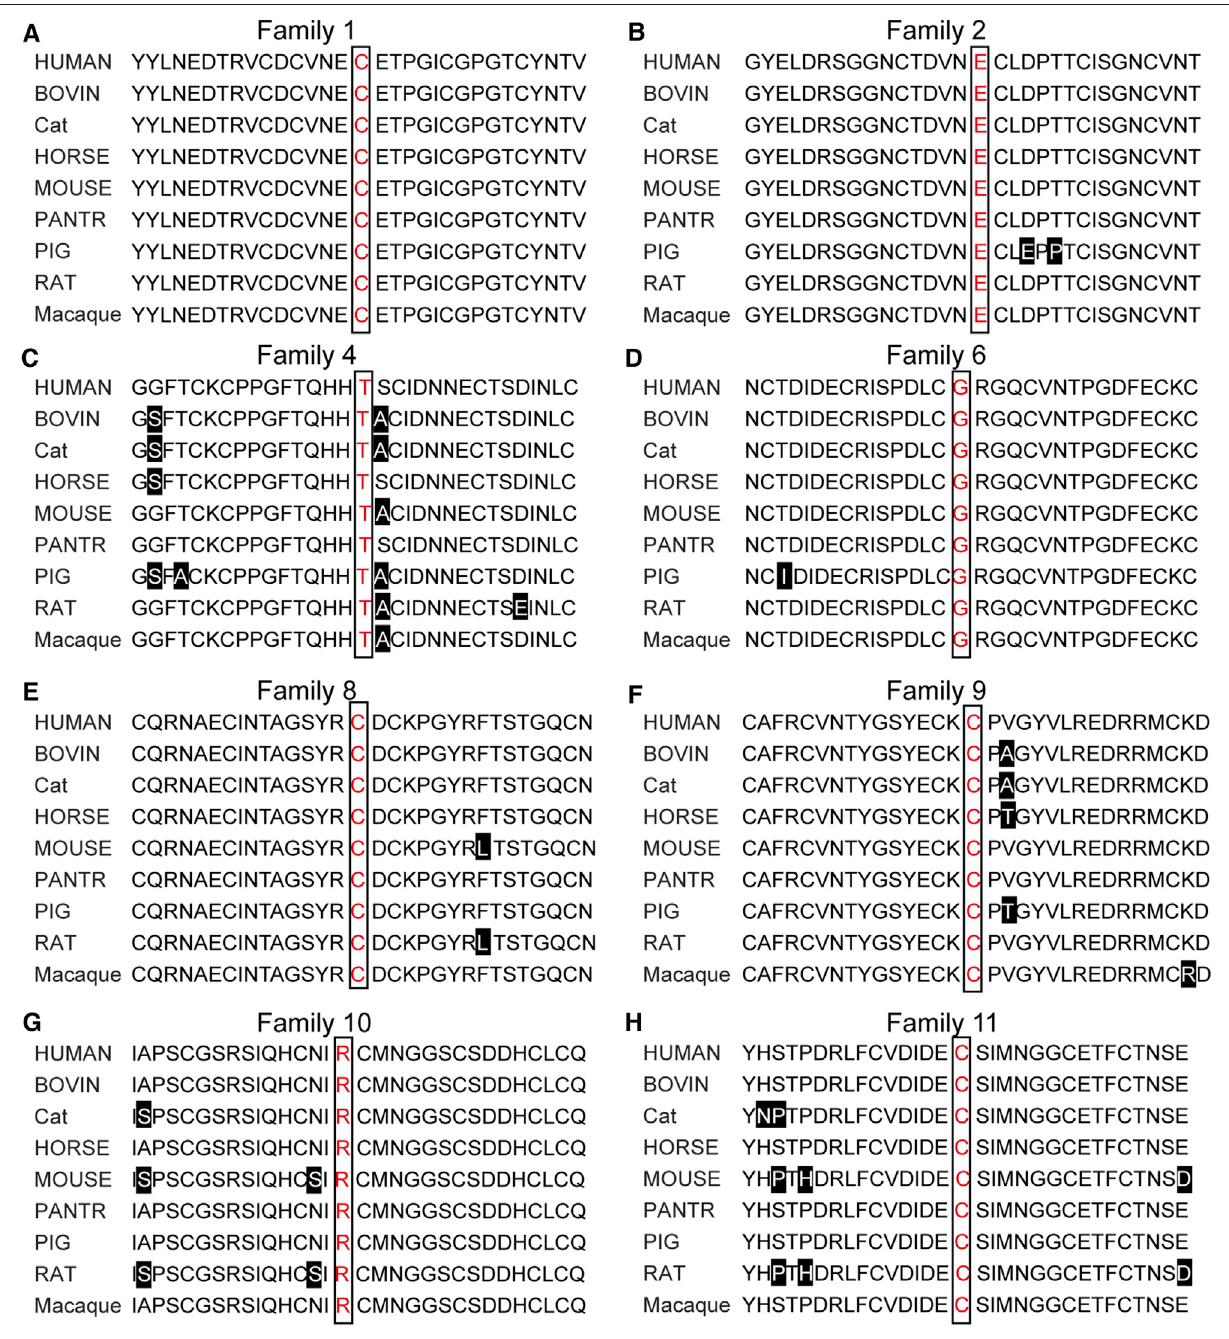
variant that likely leads to a truncated protein (PVS1). The variant is absent from all population databases (PM2), and the phenotype of affected patients is consistent with MFS (PP4). In summary, this variation is classi fi ed as “ pathogenic variation ” .